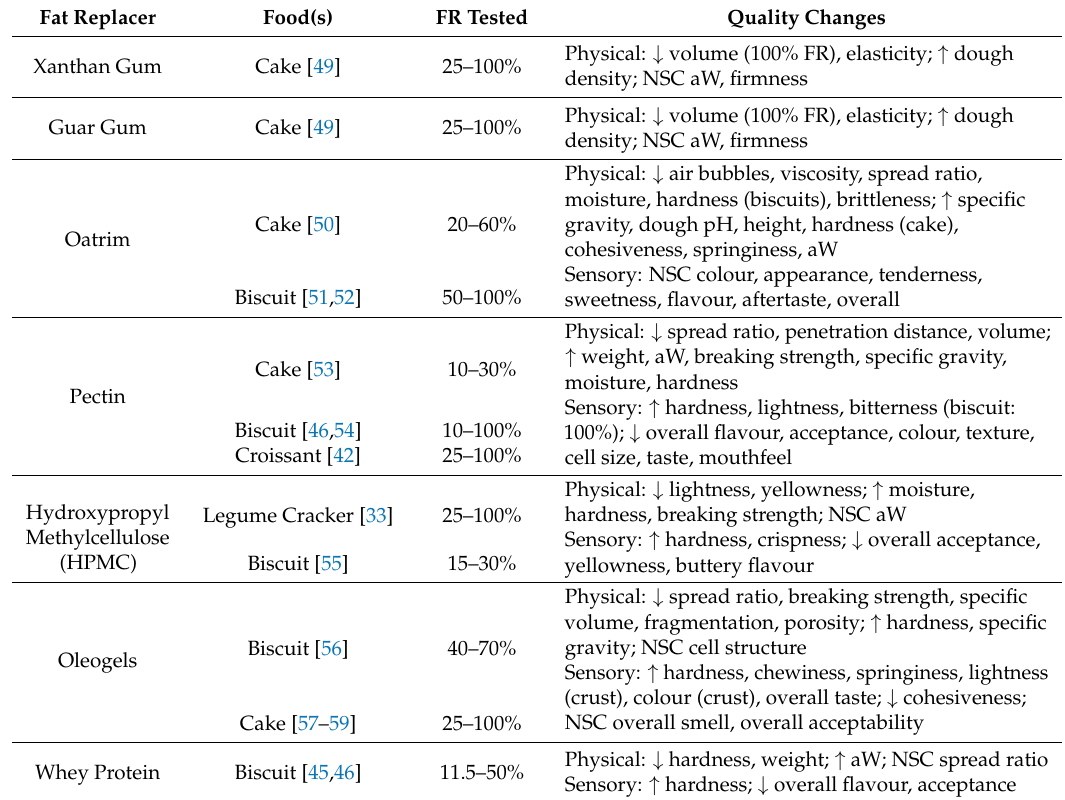
Table 2. Summary of quality changes of gum and gel fat replacers in baked food